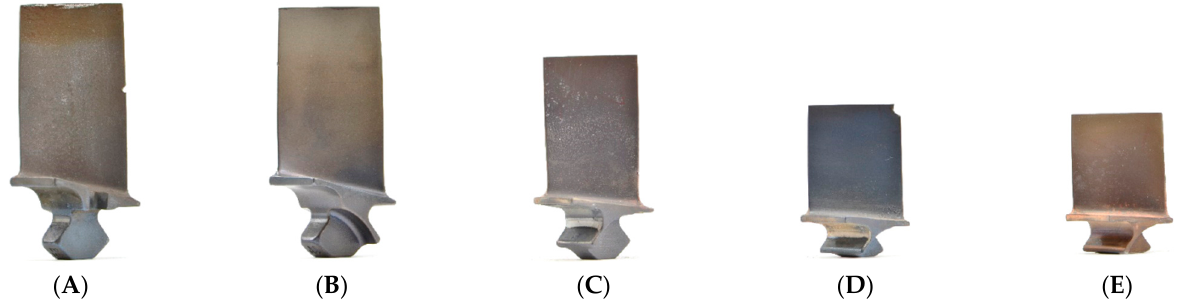
Figure 5. Sample blade defects: ( A ) nick on leading edge, ( B ) dent on trailing edge, ( C ) nick on leading edge, ( D ) teared-off corner, ( E ) dent on leading